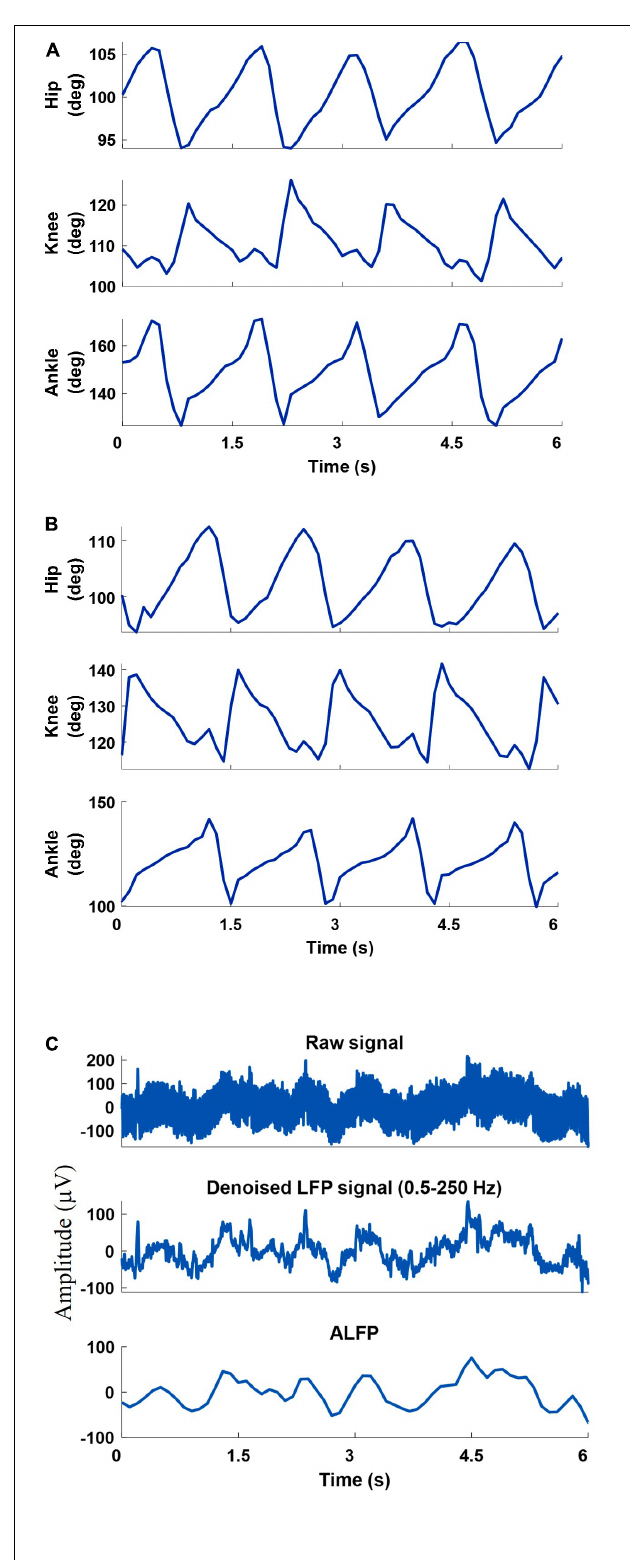
FIGURE 3 | An example of the recorded joint angles from the left leg (A) and right leg (B) , recorded raw signal, filtered raw signal (0.5-250 Hz), and amplitude of the filtered LFP signal (C)